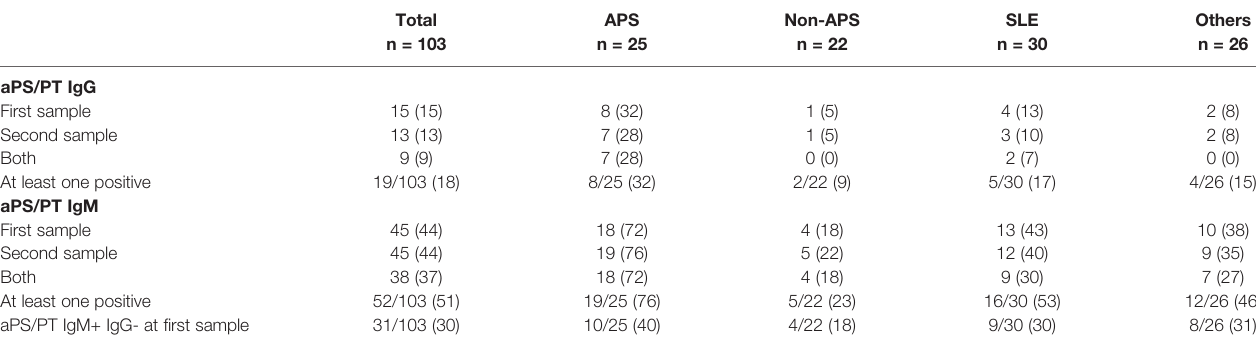
TABLE 2 | Prevalence of aPS/PT IgG and IgM antibodies by disease group.